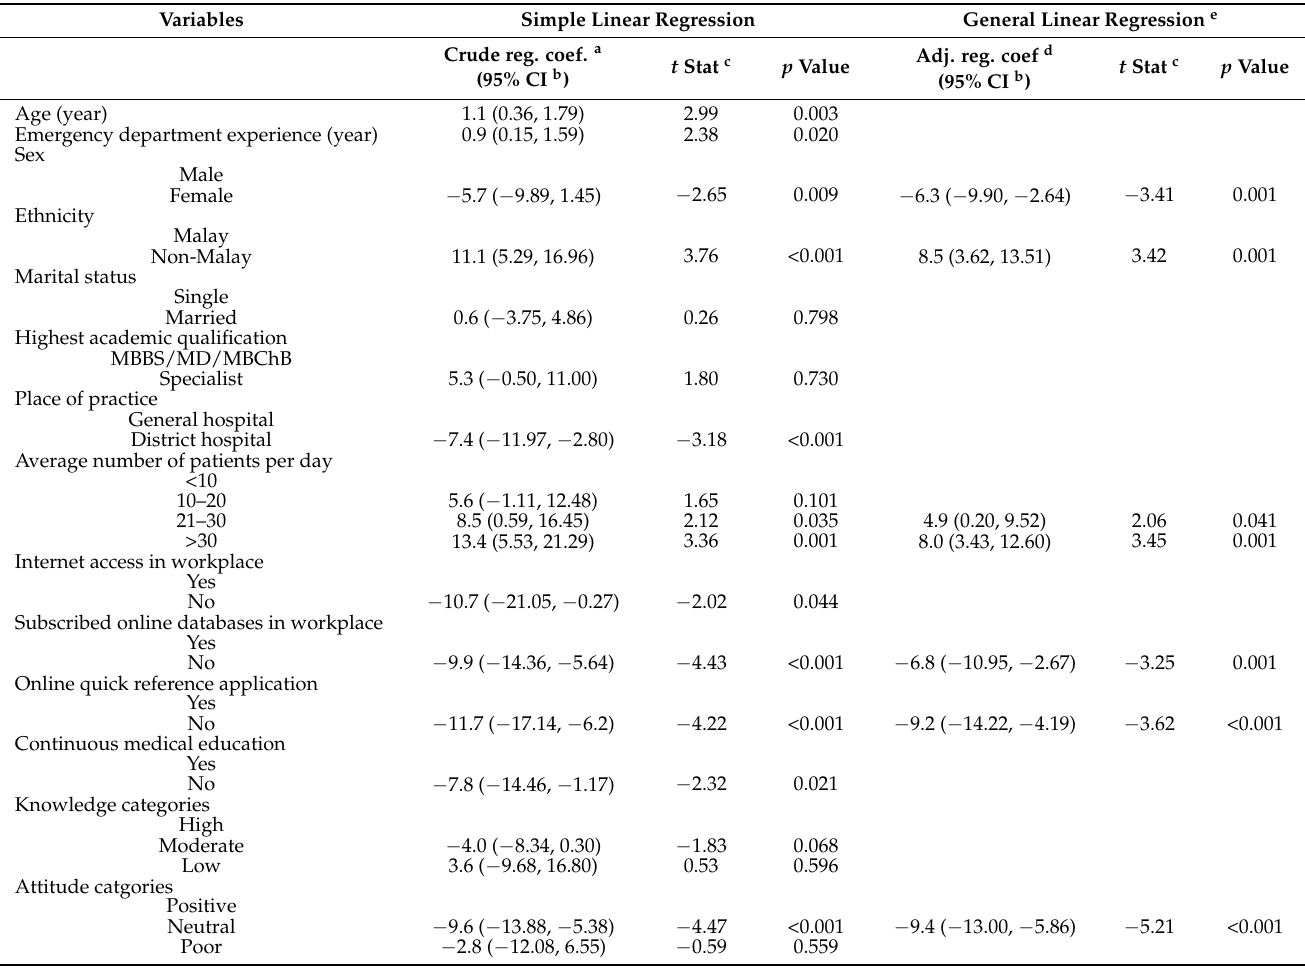
Table 2. Factors associated with EBM practice in emergency doctors using simple and general linear regression analyses ( n =